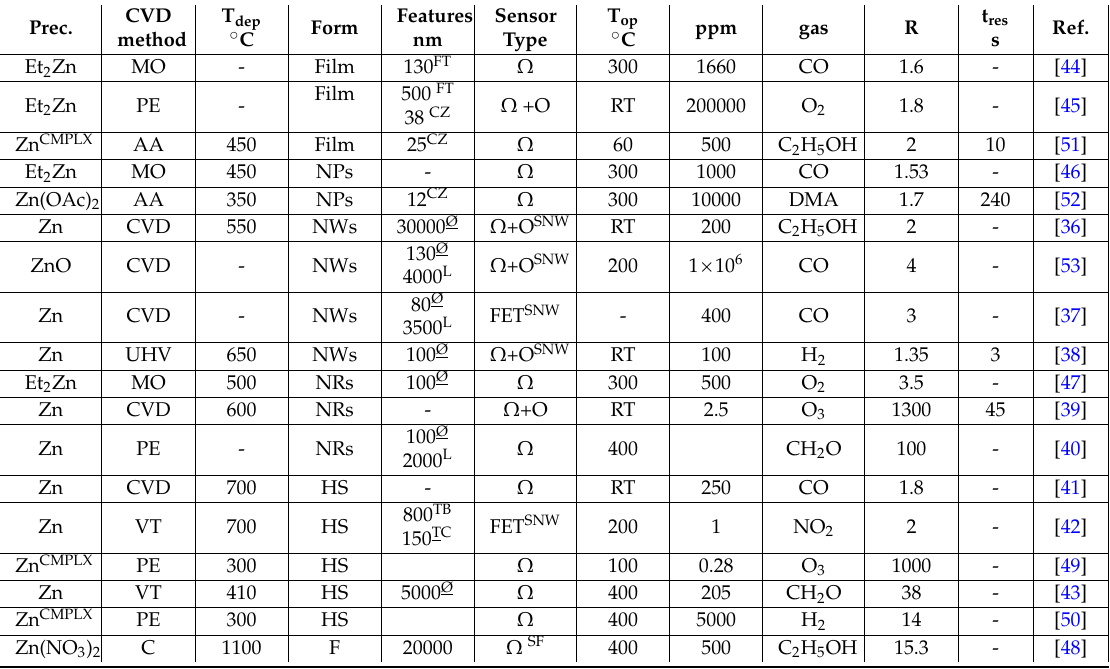
Table 2. Summary of the features and sensing properties reported for chemical vapour deposited zinc oxide.